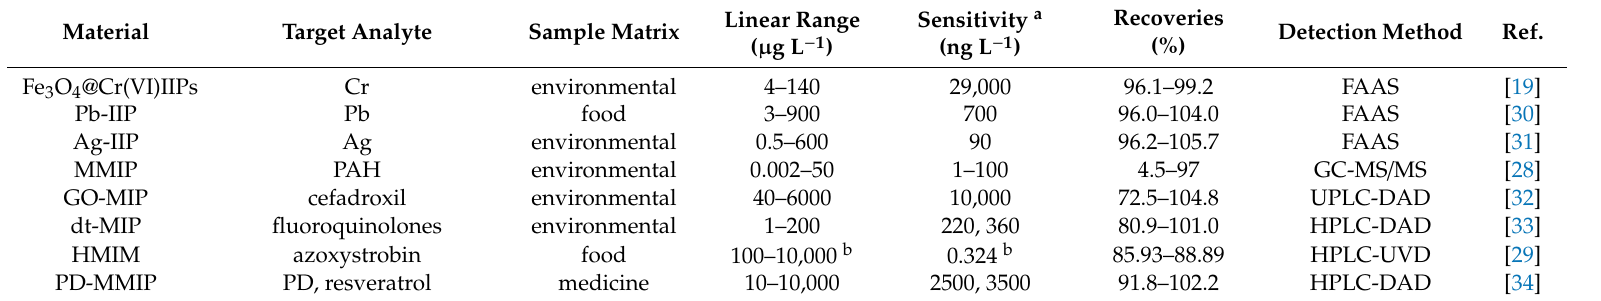
Table 3. Molecularly imprinted polymer-based